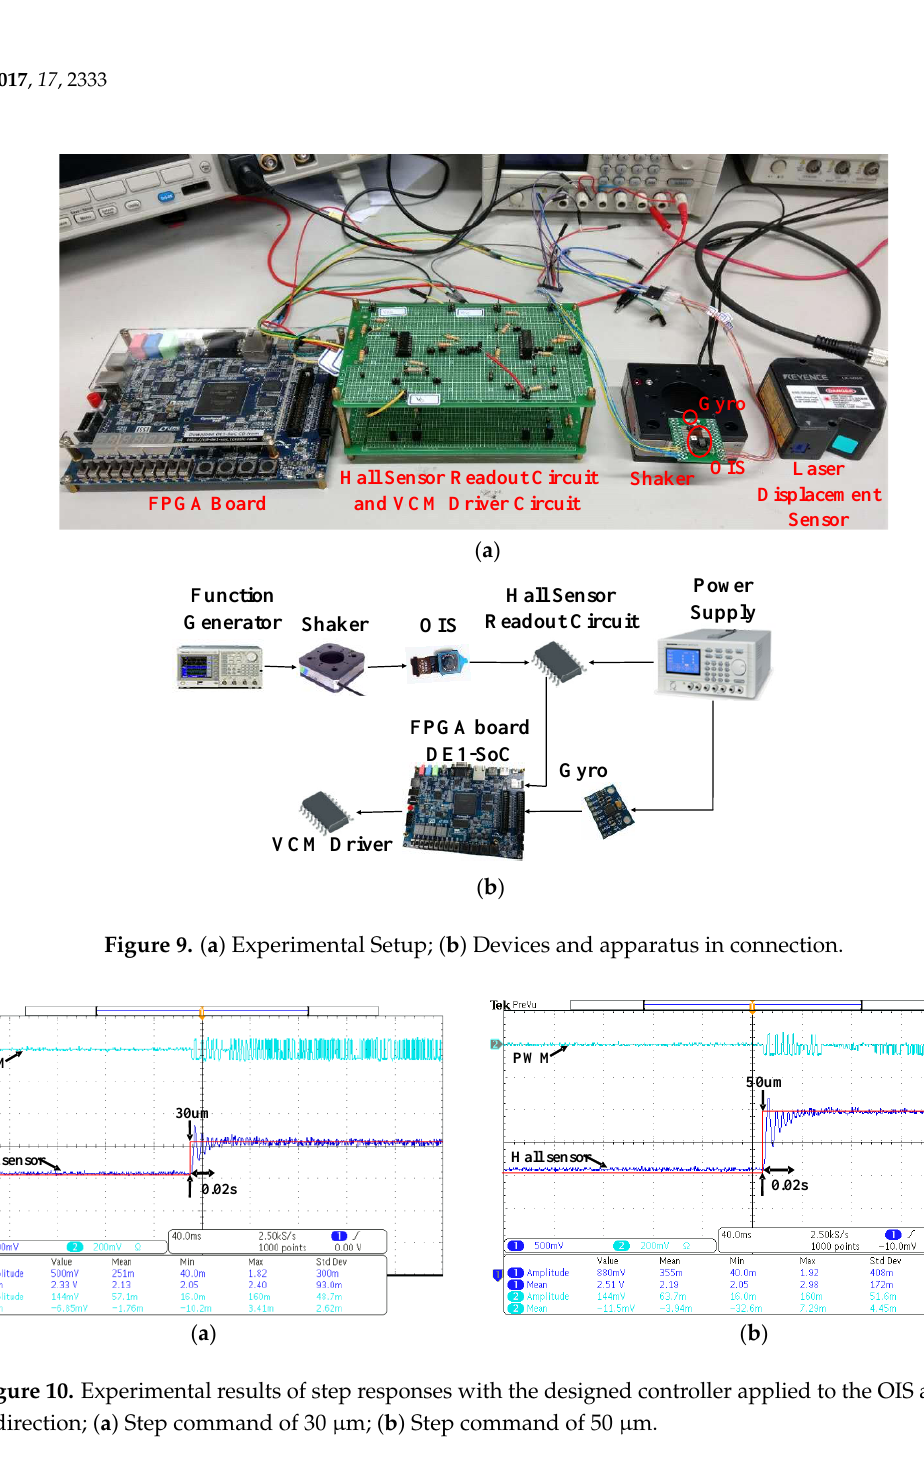
( d ) Figure 8. Simulated response of the lens holder motion relative to ground with the designed controller applied to the OIS; ( a ) 5 Hz disturbance in ±50 μm; ( b ) 10 Hz disturbance in ±50 μm; ( c ) 15Hz disturbance in ±50 μm; ( d ) 20 Hz disturbance in ±50 μm. 4.2. Experimental Results Experiments were conducted to test the performance of the designed lead-lag controller for stabilizing the lens holder relative to ground, with the aim of reducing imaging blur. Figure 9a shows the setup for conducting the experiments, while Figure 9b illustrates the connection between the device and instruments. In this experimental system, there is an OIS driven by a current drive IC to drive the the lens holder in OIS along x- and y- directions, a tranlational 2-DOF shaker to simulate hand-shaking disturbance to the OIS, an FPGA board realizing the designed lead-lag controller, and a laser displacement sensor to measure the movement of the lens holder. There are also Hall Effect sensors built into the OIS to measure the real-time motion of the lens holder relative to the OIS image base, and a gyroscope for measuring the motion of the shaker as mimicking hand shake. Figure 10 shows the experimental results of the Hall Effect sensor output for measuring the motion of the lens holder along x -direction, with PWM drive signals generated from the current drive